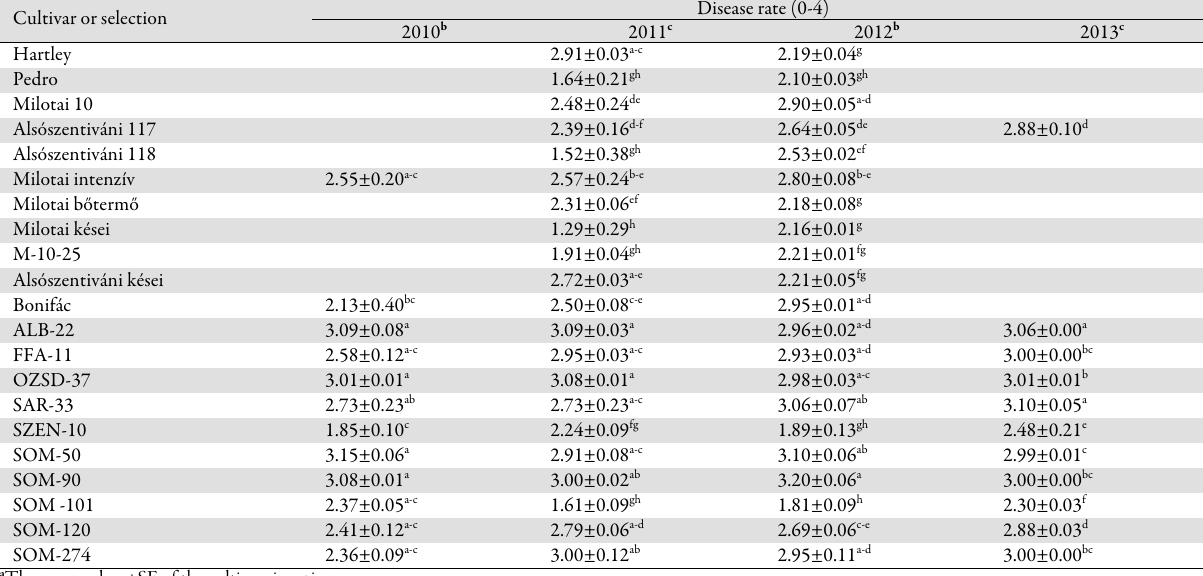
Table 3. Disease rate of the analysed walnut cultivars in the individual years a